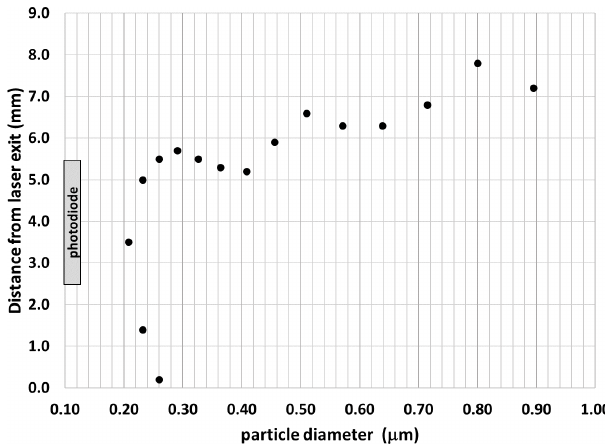
Figure 8. The model predicts that different size particles can gener- ate the same irradiance on the photodiode, depending on their loca- tion in the laser beam. In this example, each of the particles would create 1.7 × 10 − 2 pW of scattered irradiance on the